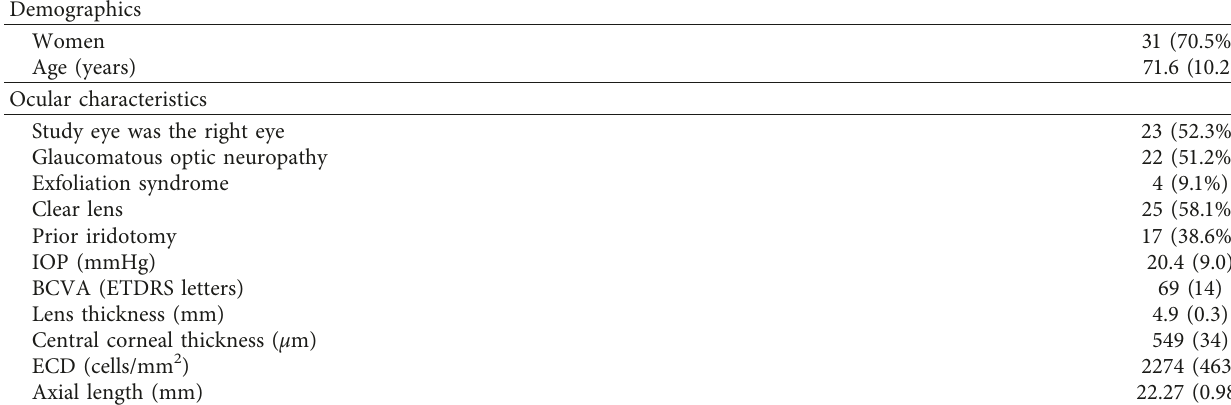
Table 1: Baseline demographics and ocular characteristics.